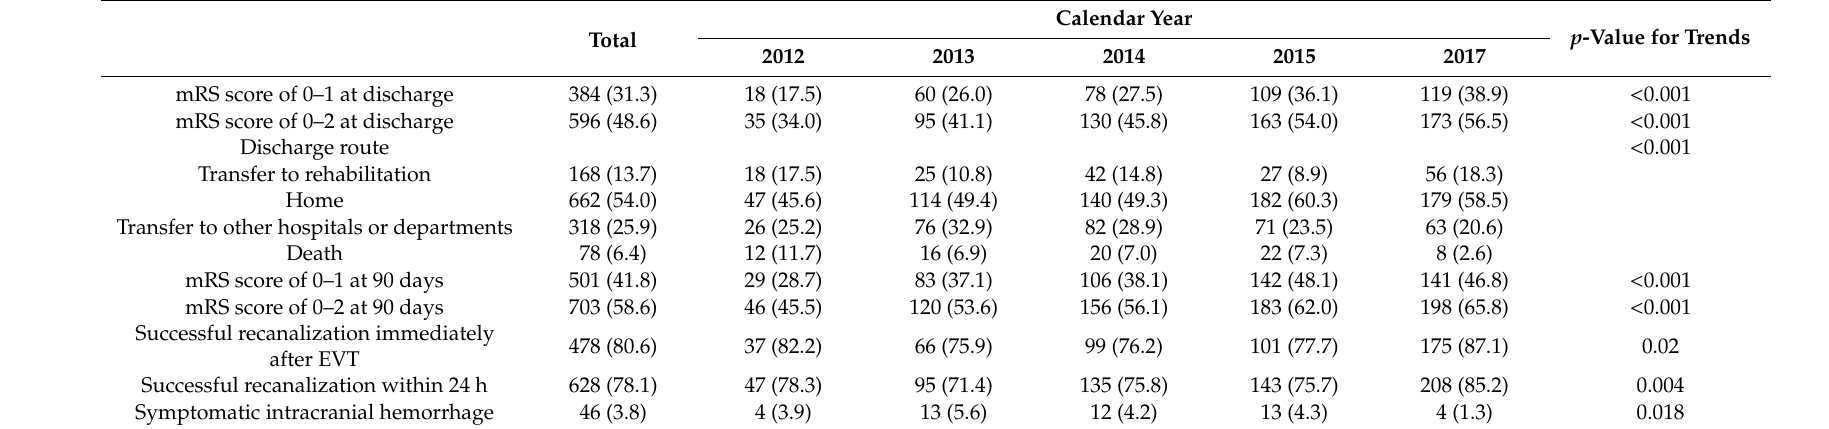
Table 2. Clinical and radiologic